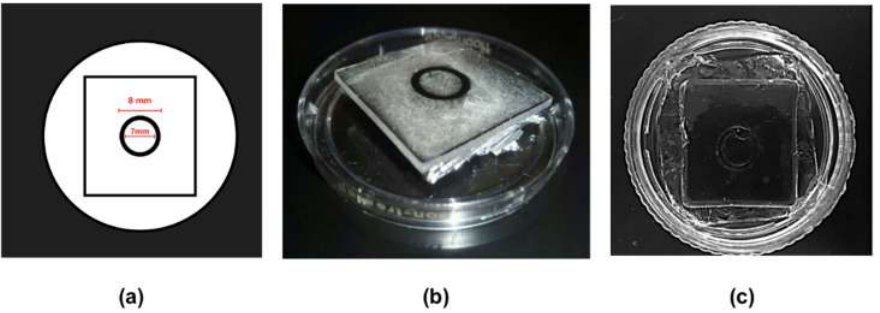
Figure 1. Fabrication of polydimethylsiloxane (PDMS) microscaffolds ( a ) Shrinky Dink® mold design, ® stamp adhered to the lid of a 3.5 mm Petri dish, ( c ) PDMS microsca ff old ( b ) Shrinky Dink® stamp adhered to the lid of a 3.5 mm Petri dish, ( c ) PDMS microscaffold replica. ( b ) Shrinky Dink